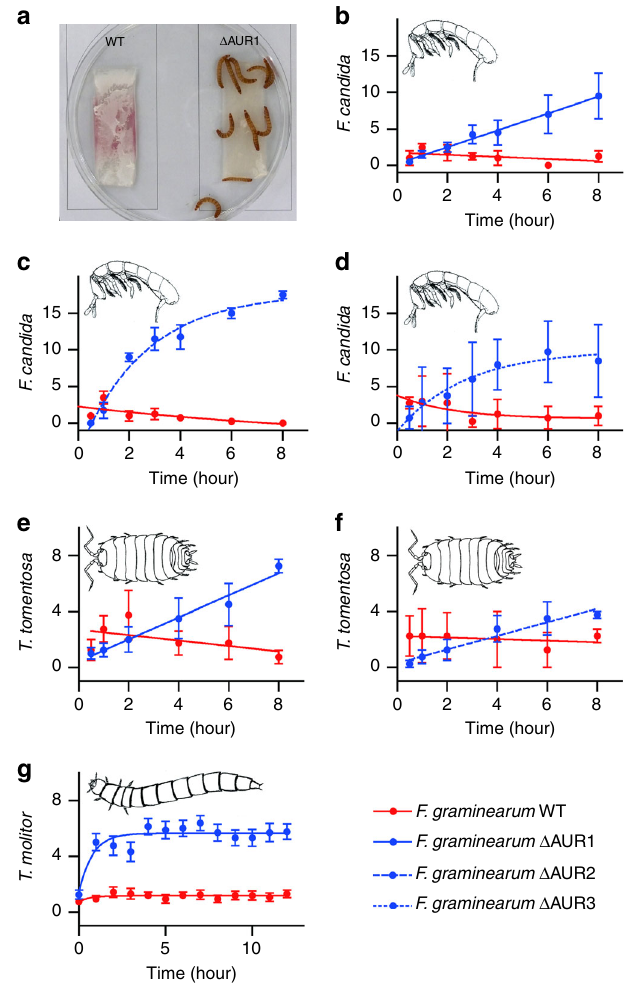
Fig. 3 Predators avoid fungal cultures in which aurofusarin